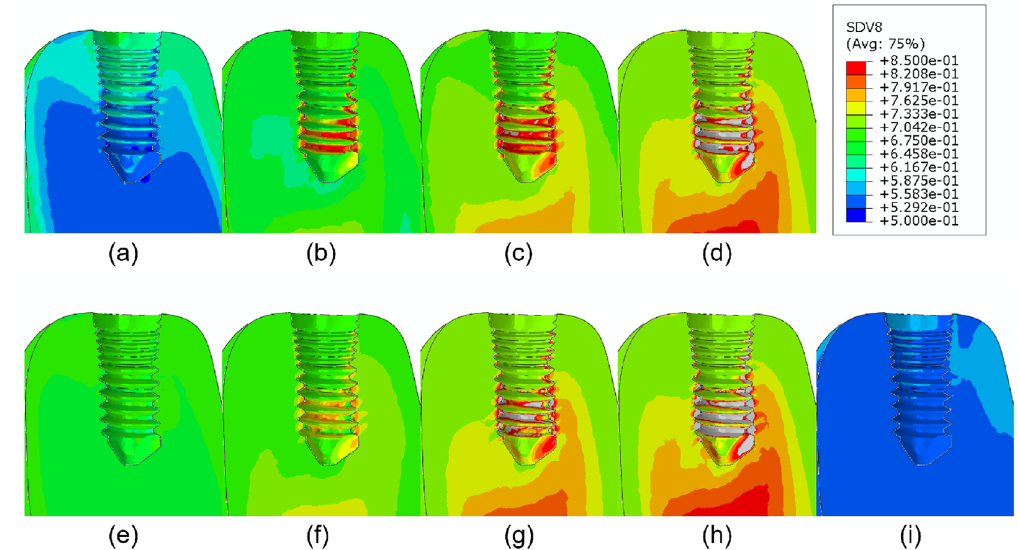
Figure 9. Ash fraction distribution after 540 days of simulation for different doses of ( a ) 0.1, ( b ) 0.3, ( c ) 1.0, ( d ) 3.0 mg/kg for denosumab and doses of ( e ) 0.25, ( f ) 0.5, ( g ) 1.0, ( h ) 2.0 mg for Ibandronate and ( i ) control implant.